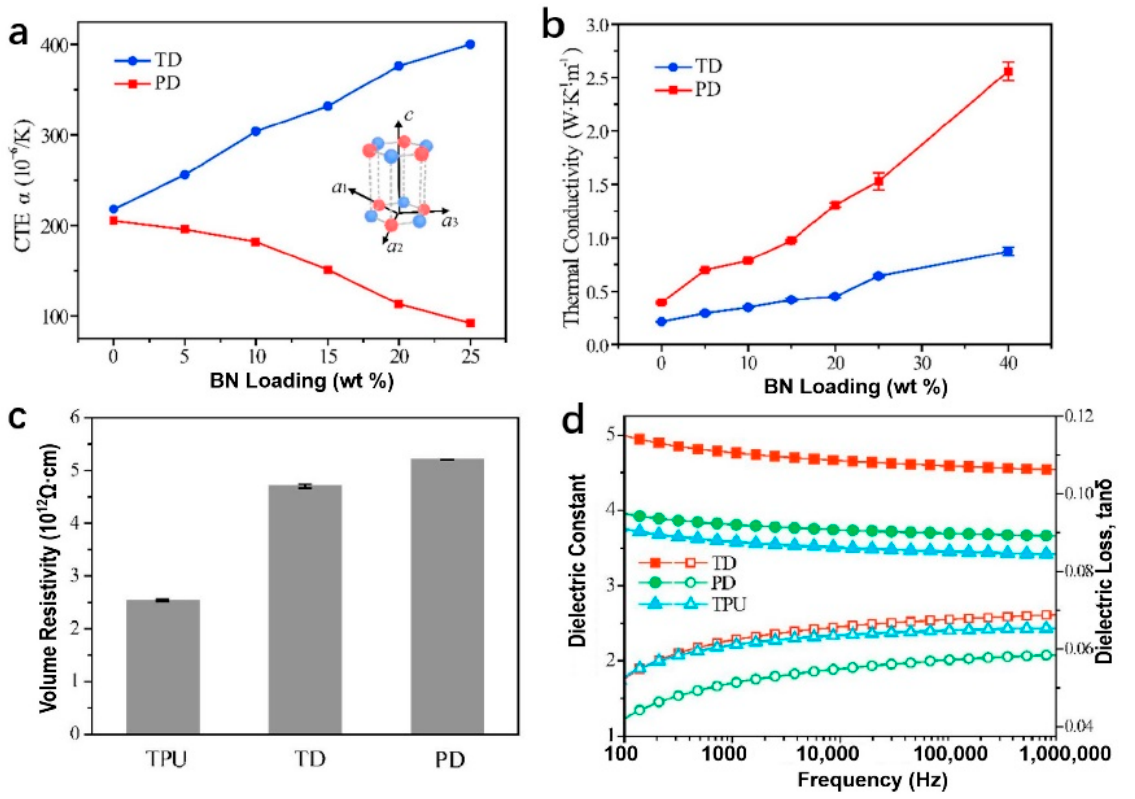
Figure 13. ( a ) The hBN/TPU composite’s coefficient of thermal expansion (CTE). The image em- bedded is a hexagonal cell; ( b ) thermal conductivity of hBN/TPU composites at 100 °C; pure TPU and 20 wt% hBN − loaded TPUs: ( c ) volume resistivity; ( d ) dielectric constant and dielectric loss (reproduced with permission from Reference [75] , Copyright 2019 Elsevier).